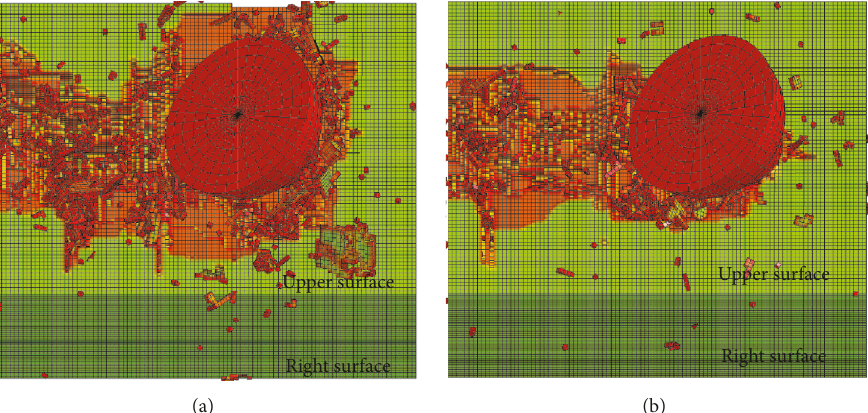
Figure 6: The cutting results with a cutting depth of 9mm for sandstone-1: (a) the cutting results with a cutting speed 1m/s and (b) the cutting results with a cutting speed of